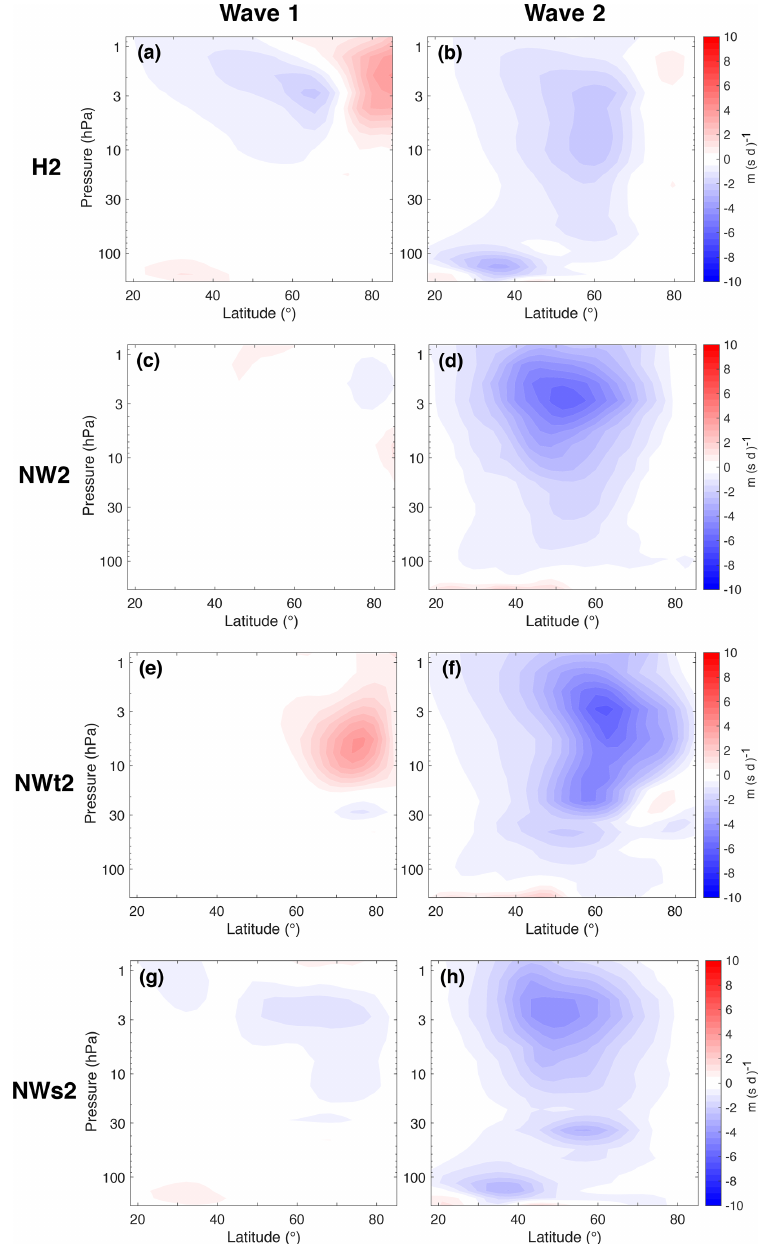
Figure 4. Divergence of EP flux for H2 (a, b) , NW2 (c, d) , NWt2 (e, f) and NWs2 (g, h) . (a, c, e, g) Wave 1 components. (b, d, f, h) Wave 2 components. The contour interval is 0.5m ( sd ) − 1